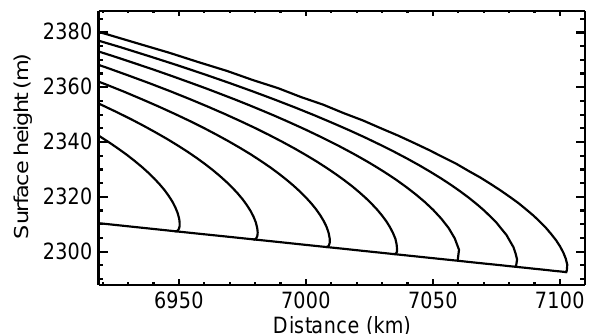
Fig. 15. Glacier advance calculated with a altitude-dependent mass balance distribution over the whole glacier as used in Leysinger Vieli and Gudmundsson (2004) and shown using the same scale as in Fig. 2a.